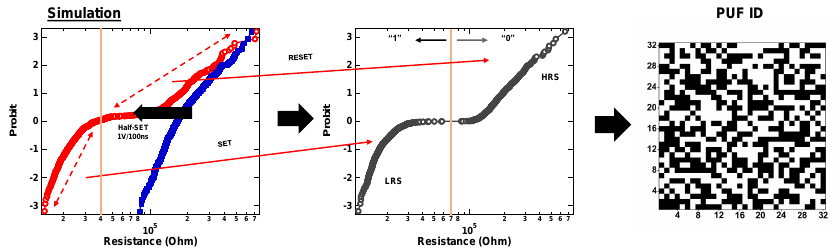
Figure 7: The PUF implementation method relies on (i) first applying a SET pulse aiming at half of the population in LRS, (ii) reading and subsequent reinforcement of LRS and HRS aiming at eliminating the unstable bits. The threshold to determine high/low resistance for the reinforcement is 40